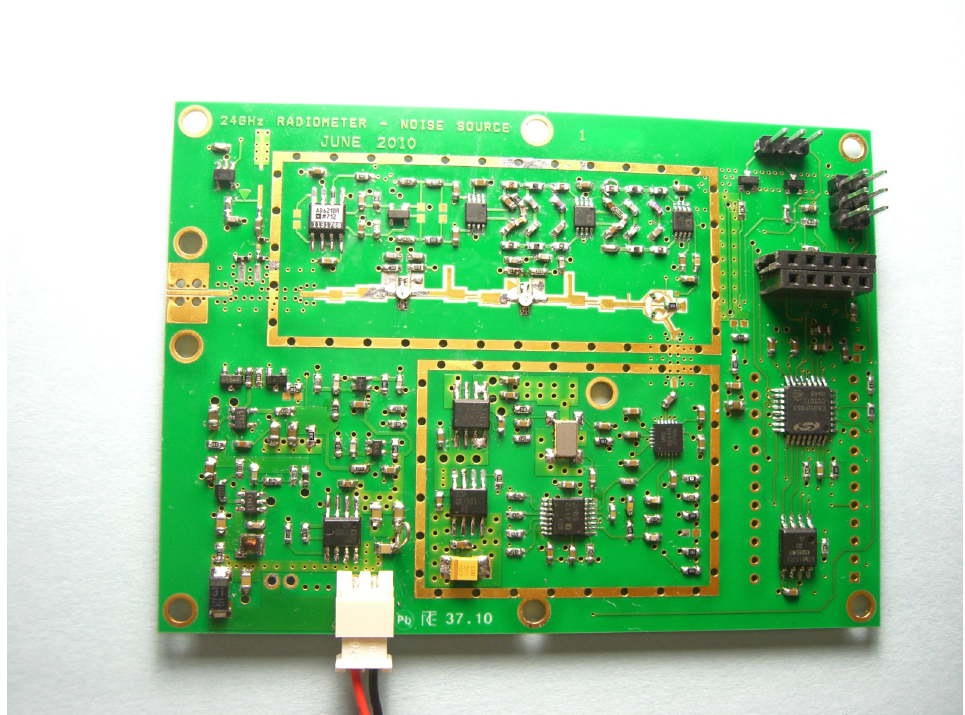
Figure 7. Photo of the single-board, 24-GHz radiometer